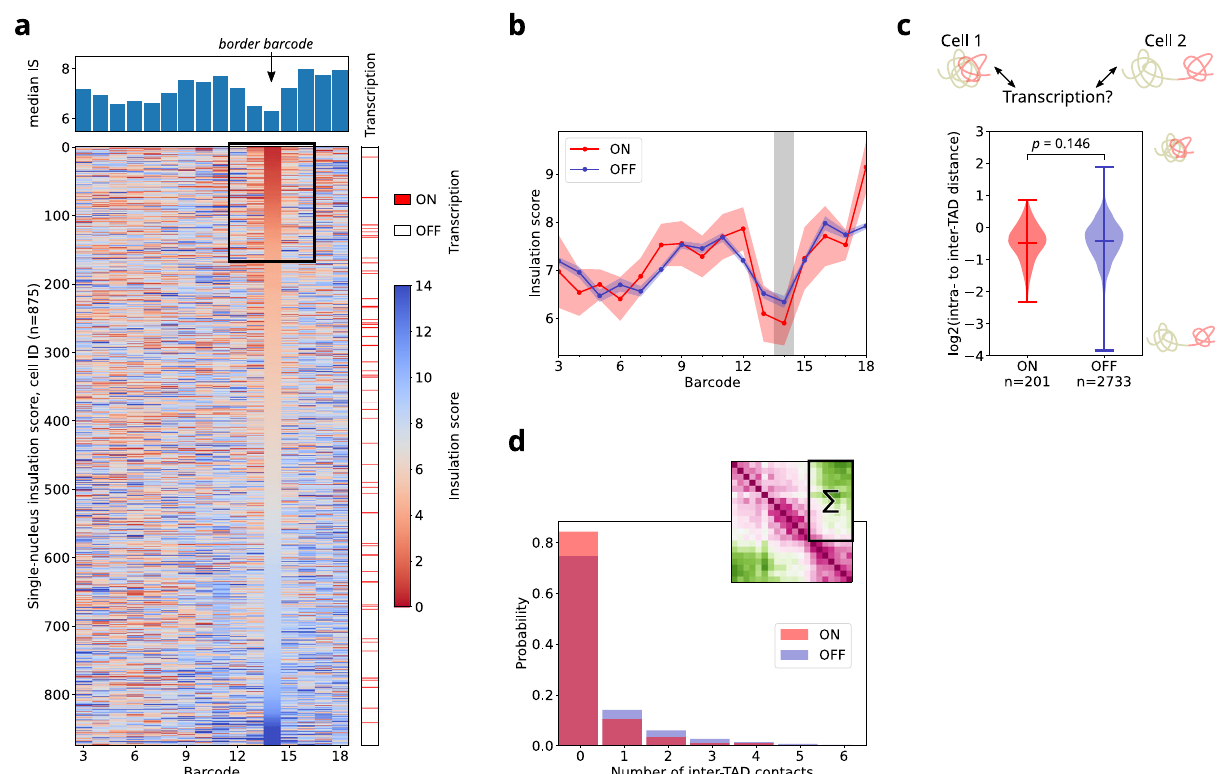
Fig. 4 | Single-nucleus TAD insulation and intermingling with a neighboring TAD are independent of transcriptional activity. a Top: Ensemble-average (median) pro fi le of the insulation score for nc14 embryos. Bottom: Single-nucleus insulation score, number ofnuclei: n =875.Eachline corresponds to the insulation score pro fi le of an individual nucleus, with values color-coded from red (small insulation score, i.e., strong insulation) to blue (large insulation score, i.e., weak insulation).NucleiaresortedaccordingtotheirinsulationscoreattheTADborder. The right-most lane indicates the transcriptional state of each nucleus, with active nuclei marked red. The black frame highlights the ~20% of nuclei with a high insulation (i.e. a low insulation score) at the ensemble TAD border. b Ensemble- average pro fi le of the insulation score for active (red) and inactive (blue) nc14 nucleishownin a .CirclesindicatethemedianISforeachbarcode.Theredandblue